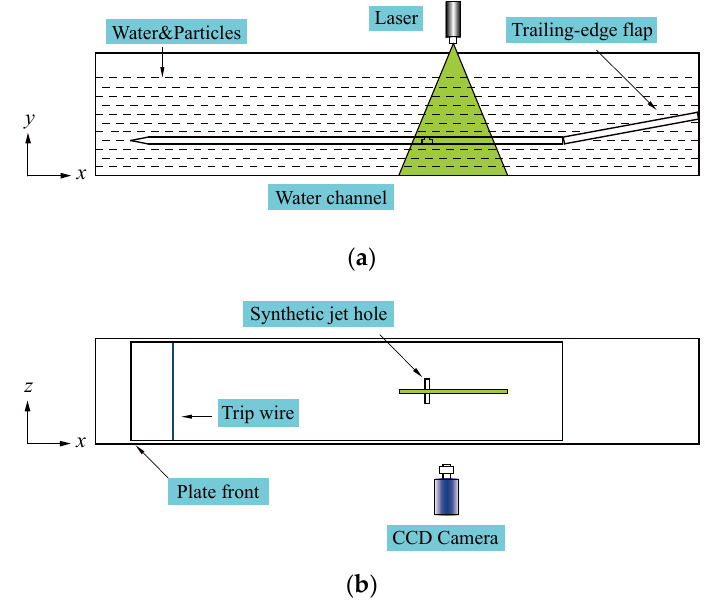
Figure 1. Experimental setup: ( a ) Front view; ( b ) Top view.